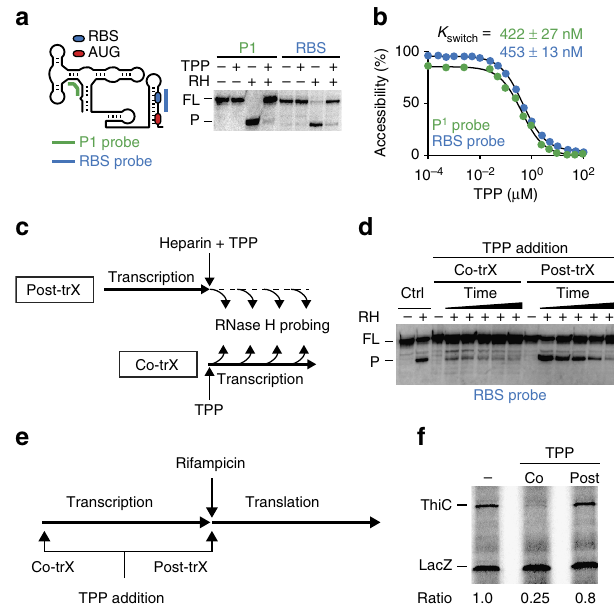
Figure 2 | The thiC riboswitch performs TPP sensing cotranscriptionally. ( a ) Schematic of the construct used for RNase H probing assays and the locations of P1 (green) and RBS (blue) probes. The right panel shows RNase H assays performed in the absence ( (cid:2) ) or presence ( þ ) of TPP or RNase H (RH), using the P1 or RBS probe. The full-length (FL) and cleaved product (P) are shown on the left. ( b ) K switch determination for the wild-type riboswitch. In vitro transcription reactions were done in presence of increasing TPP concentrations ranging from 100pM to 100 m M. Experi- ments were done in triplicate and the data shown are a representative result. ( c ) Experimental setup monitoring TPP binding to the thiC riboswitch. Post-transcriptional TPP binding (Post-trX) was assessed by performing transcription in absence of TPP. After stopping transcription, TPP is added and RNase H assays are performed at several time points. Cotranscriptional TPP binding (Co-trX) was assessed by adding TPP before transcription initiation and by performing RNase H assays during transcription. ( d ) RNase H probing assays monitoring TPP binding to the thiC riboswitch. Control reactions (Ctrl) done in presence of RNase H (RH) show a cleaved product (P) without TPP. Post-transcriptional and cotranscriptional reactions were performed as indicated in c . The FL and P are indicated on the left. ( e ) Experimental setup monitoring TPP binding using transcription–translation in vitro assays. The effect of post- transcriptional (Post-trX) TPP binding was assessed by initiating the transcription reaction in absence of TPP. After the addition of rifampicin, amino acids and TPP were added to allow TPP binding to the riboswitch during translation. The cotranscriptional (Co-trX) TPP binding was assessed by adding TPP at the beginning of transcription. ( f ) Transcription–translation in vitro assays assessing TPP binding to the riboswitch. Reactions were performed in absence ( (cid:2) ) or presence of TPP added either cotranscriptionally (Co) or post transcriptionally (Post) as indicated in e . Ratios of ThiC expression normalized to that of